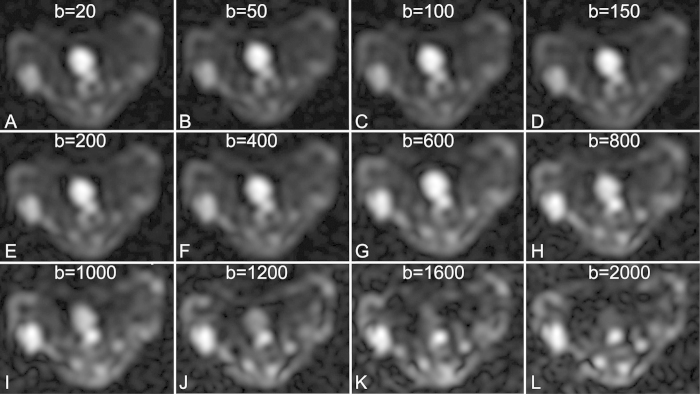
IVIM DW images with 12 b-values (A–L) for 0, 20, 50, 100, 150, 200, 400, 600, 800, 1200, 1600, and 2000 s/mm2.